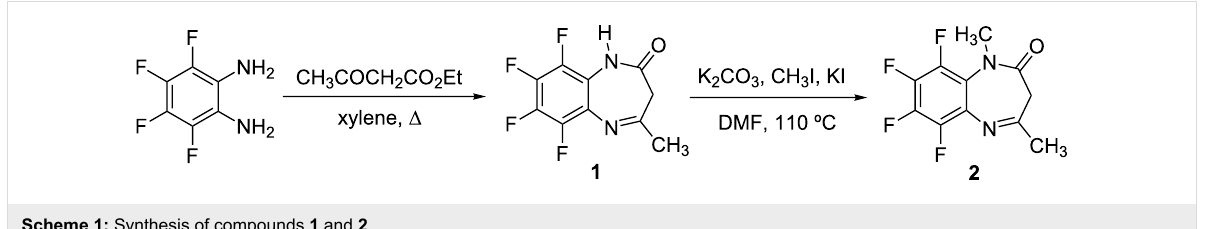
Scheme 1: Synthesis of compounds 1 and 2 .